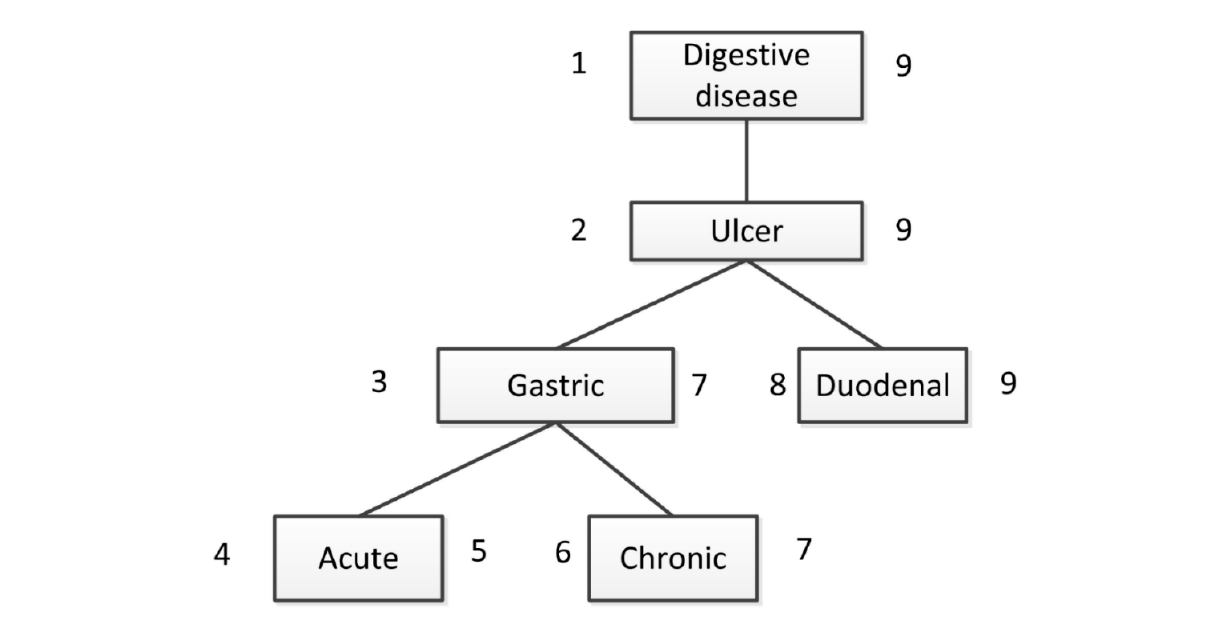
Figure 4. Example of a nested-set model of